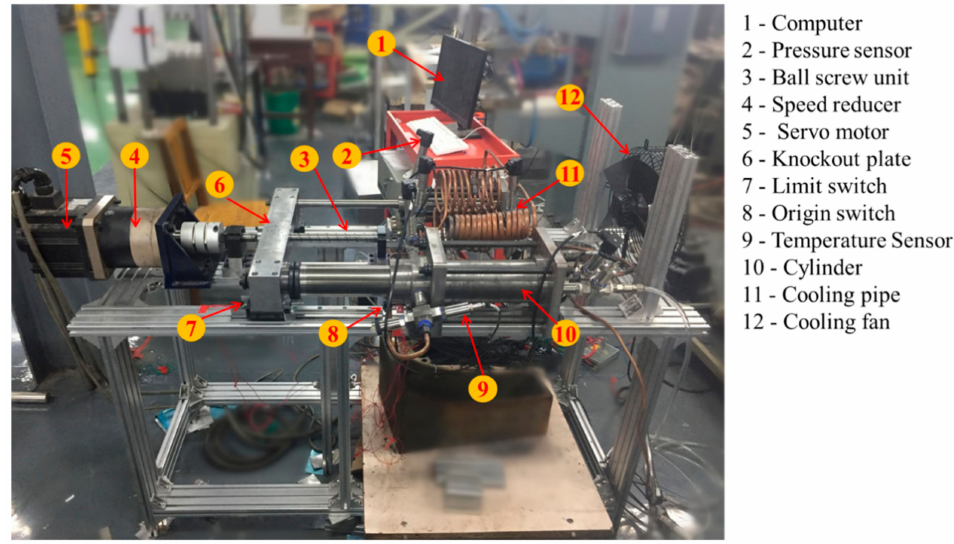
Figure 8. Prototype of the developed compressor